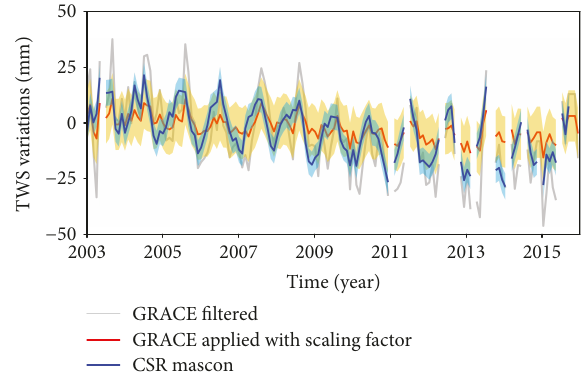
Figure 7: Monthly variations of terrestrial water storage derived from GRACE and CSR mascon data products. The orange and blue shadows represent the uncertainties in TWS variations from GRACE and CSR mascon. The uncertainties of CSR mascon solutions and the GRACE TWS with the scaling factor are computed to be around 6mm and 12mm, respectively (see Section 4.4).